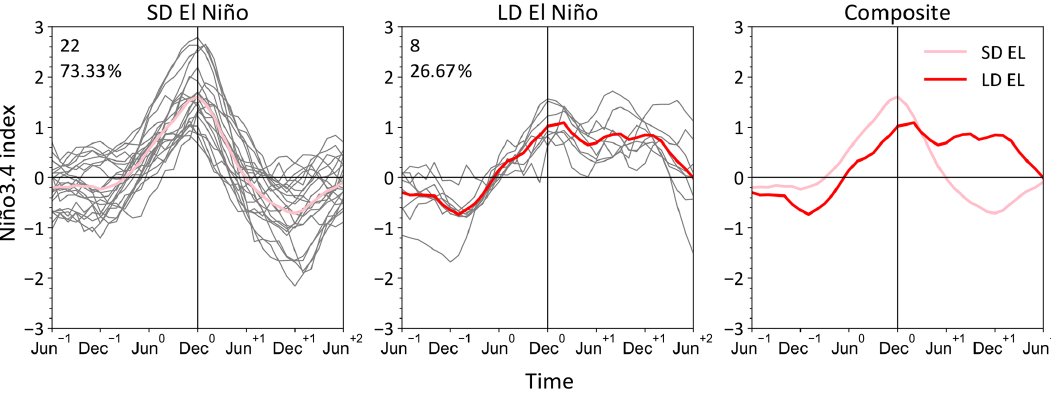
Figure 2. Time series of the Niño 3.4 index ( ◦ C) overlaid from Jun − 1 to Jun + 2 for (left) SD and (middle) LD El Niño events during 1870– 2017. The individual and composite events are shown by thin gray and bold red curves, respectively. The total number and percentage of events are shown at the upper left corner of each panel. A comparison of the composite time series of Niño 3.4 index for SD and LD events is shown in the right